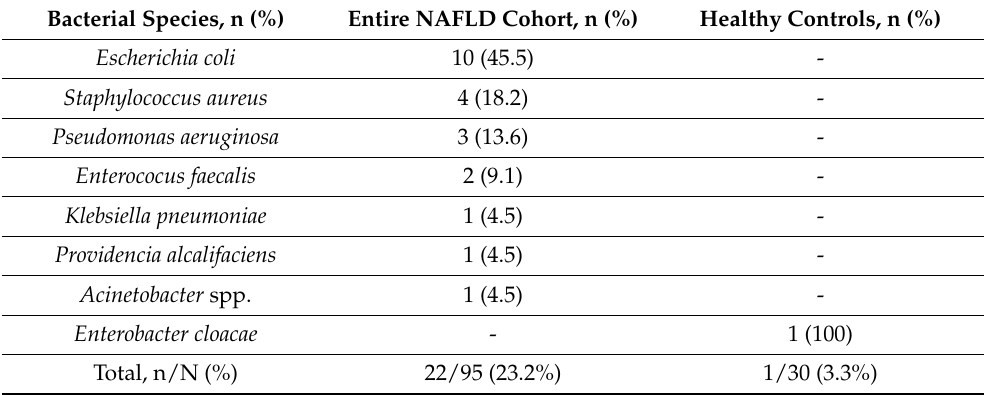
Table 2. Bacterial species from duodenal aspirates of study participants with small intestinal bacterial overgrowth